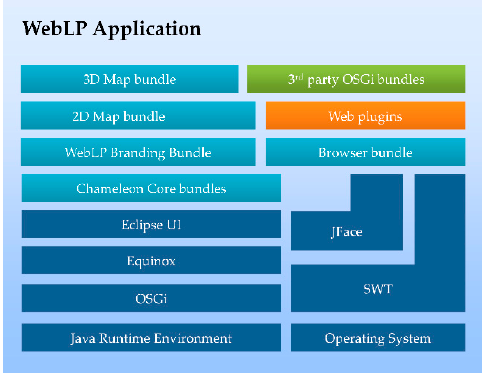
Figure 13. The Web Learning and Planning platform modular architecture.